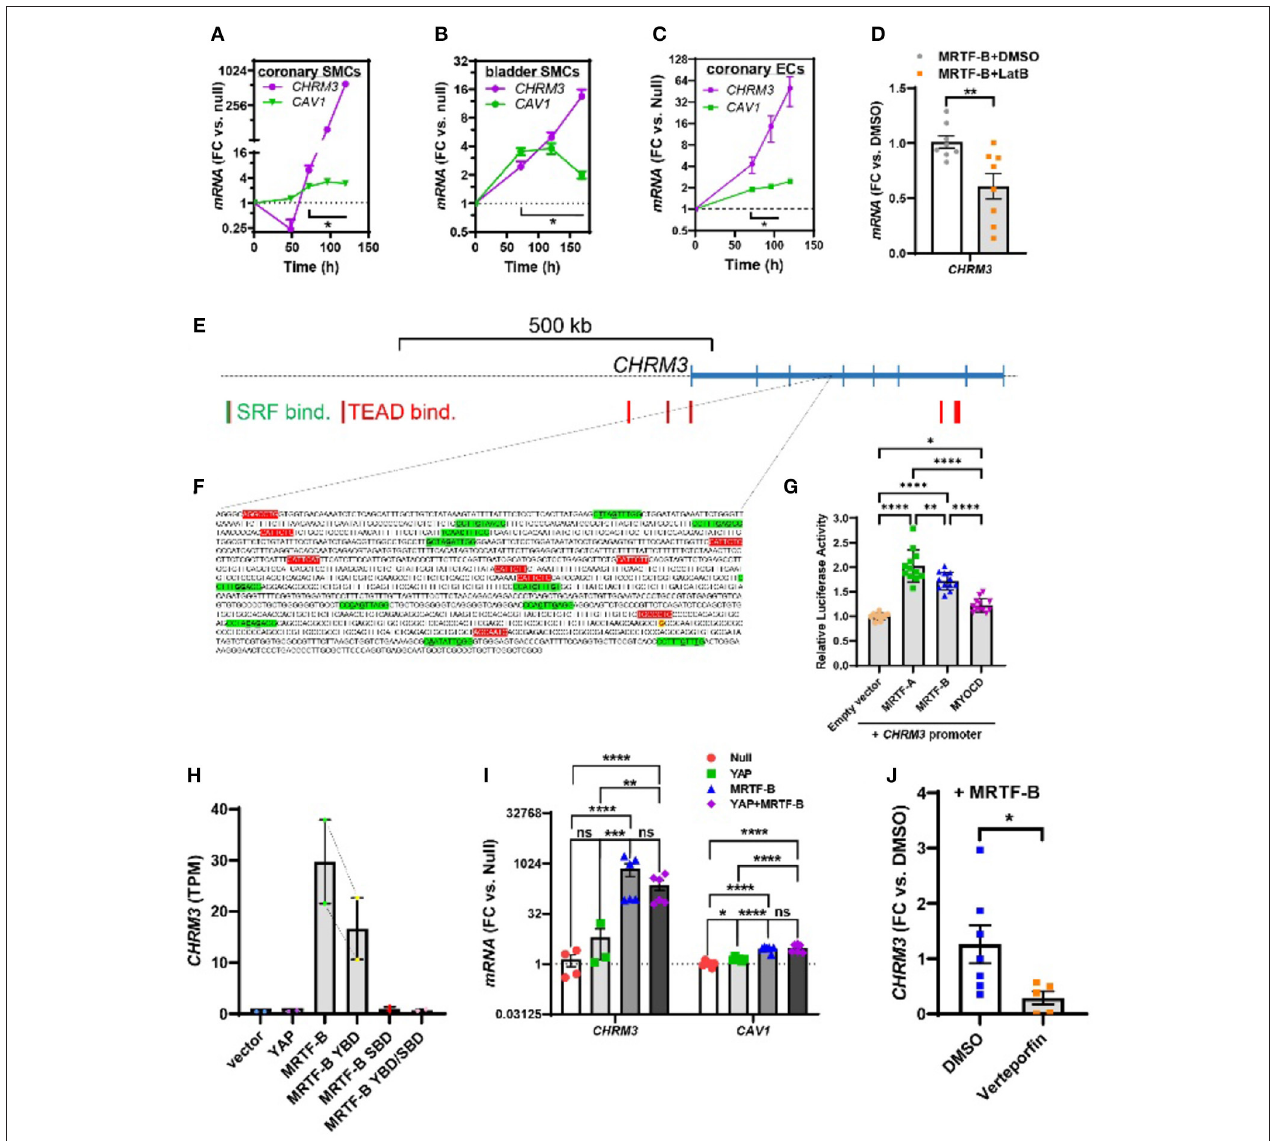
FIGURE 3 | Time-course data, promoter reporter assays, and MRTF-B-YAP cooperation. MRTF-B was overexpressed in different cell types (200 MOI), and cells were harvested at different times. RNA was subsequently isolated, and CHRM3 was measured by RT-qPCR. (A) Shows time-dependent upregulation of CHRM3 in human coronary artery SMCs. Significant increases were seen at times exceeding 48h, and a 597-fold increase was seen at 120h ( p = 0.0004, n = 3). Because there was no indication that the increase of CHRM3 reached a plateau at longer transduction times, we designed an experiment using even longer incubations in human bladder SMCs (B) . Again, there was no tendency of a plateau. Moreover, the maximal increase was somewhat smaller than in coronary artery SMCs. Similar results were obtained in human coronary artery endothelial cells [ (C) , 200 MOI]. (D) Shows that CHRM3 was reduced by Latrunculin B (100nM, gray bar) in MRTF-B-transduced ECs. Inspection of the CHRM3 gene locus on chromosome 1 (E) revealed SRF binding (green vertical bars) and TEAD binding (red vertical bars) to many 5’ sequences of, and over, the longest transcript (blue). Direct examination of a commercial promoter reporter sequence (NM_000740, transcript variant 2, hg38; chr1 + : 239,627,686–239,629,364; TSS = 239,629,073) did not reveal any true CArGs, but 11 motifs with 2 deviations from the classical CArG sequence [CC(A/T)6GG, green highlights, deviations underlined, (F) ] were present, along with 9 TEAD motifs [red highlights, (F) ]. The transcription start site for the promoter is highlighted in yellow with red lettering. This “CArG-deficient” promoter responded to MRTFs in a luciferase reporter assay (G) run using HEK 293 cells. (H) Shows CHRM3 mRNA expression in MCF10 cells transfected with YAP, MRTF-B, and two MRTF-B mutants; the YBD mutant does not bind YAP, and the SBD mutant does not bind SRF. (I) Shows the effects of YAP and MRTF-B transduction, alone and in combination, on CHRM3 in human coronary artery SMCs. Ct values for CHRM3 were sometimes too high for reliable detection (null and YAP). This is the reason why the sample size is less than n = 6 for CHRM3 in the null and YAP groups, even if six experiments were run for the panel. (J) Shows the effect of the YAP-TEAD inhibitor verteporfin in MRTF-B-transduced coronary artery SMCs. Two samples were lost in the verteporfin group again due to lack of amplification. **** p < 0.0001, *** p < 0.001, ** p < 0.01, and * p < 0.05.